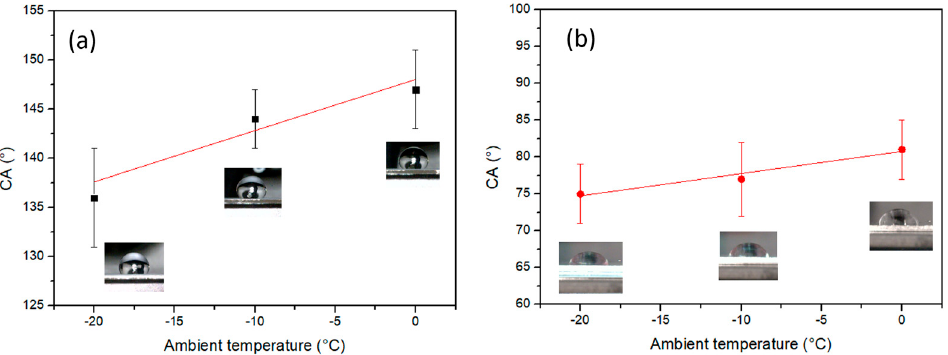
Figure 5. Evolution of the contact angle ( CA ) with the ambient temperature. The 10 μL drops were gently deposited on ( a ) the micromachined sample ( h = 50 µ m), black square) and ( b ) on the pristine gently deposited on ( a ) the micromachined sample ( h = 50 µm), black square) and ( b ) on the pristine one (red one (red circle).